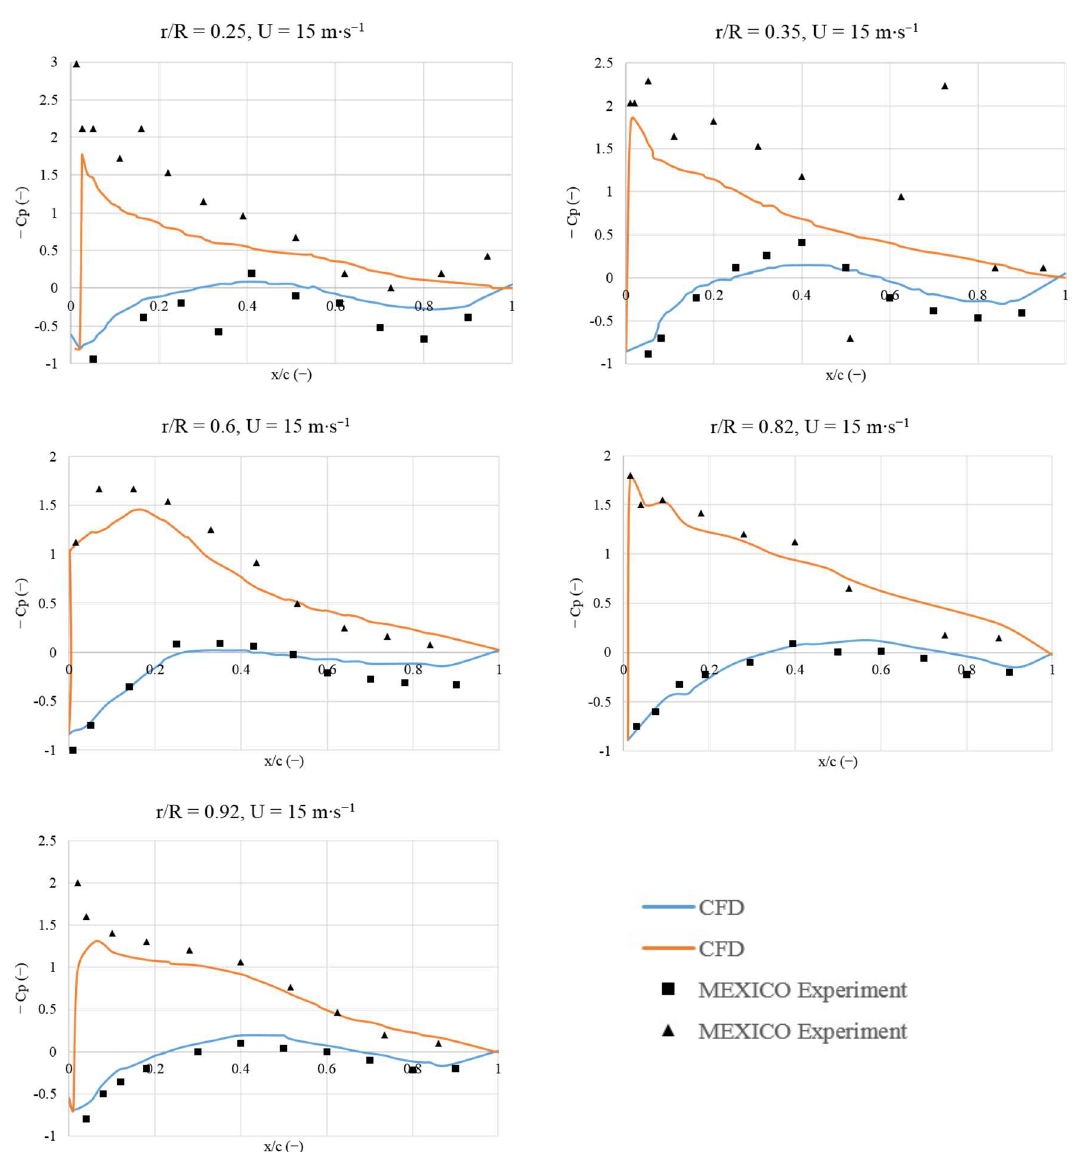
Figure 6. Normalized pressure coefficient on the blades for U = 15 m ∙ s − 1 , TSR = 6.6 and θ = − 2.3°.